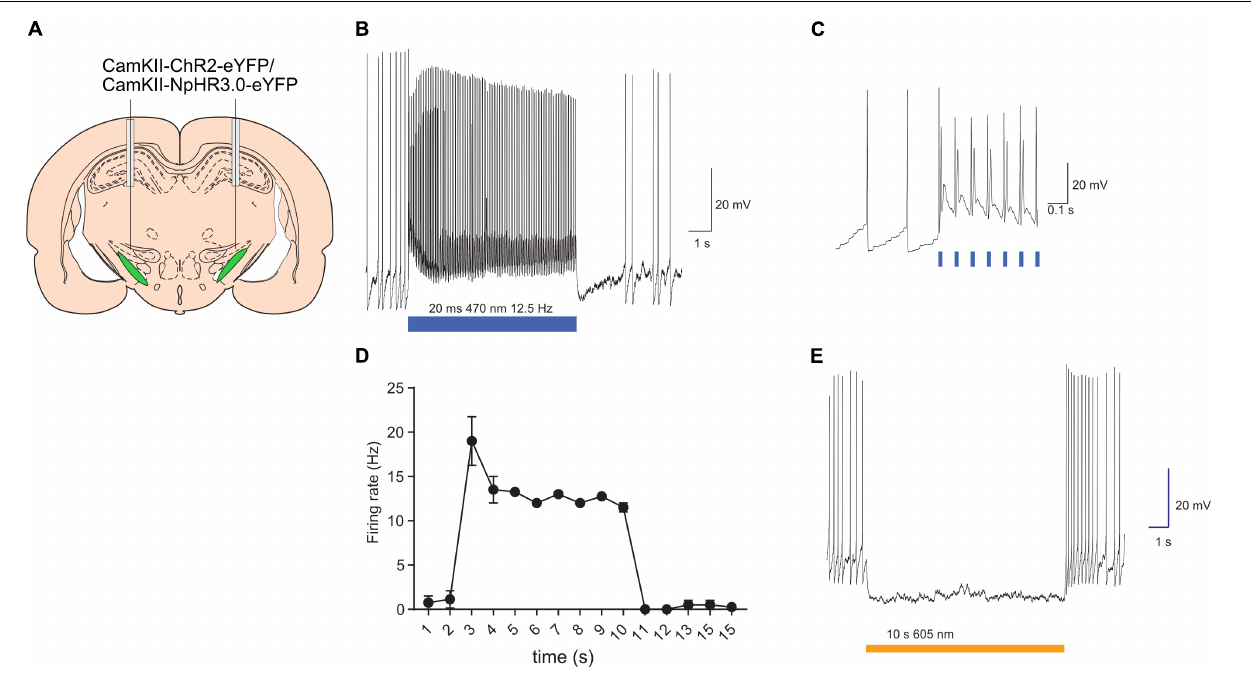
FIGURE 1 | Validation of opsins activity with in vitro electrophysiology. Schematic of subthalamic nucleus targeting of opsins (A) . Example of light-evoked excitation of ChR2-expressing neurons (B) . Light-evoked excitation shown on an expanded timescale to revealing synchrony between light onset and action potential generation (C) . Summary data plotting mean ( ± SEM; n = 4) firing frequency in presence and absence of light stimulation (D) . Example of light-evoked suppression of neuronal firing in eNpHR3.0-expressing neurons (E) . Bars indicate timing of light presentations. * p <